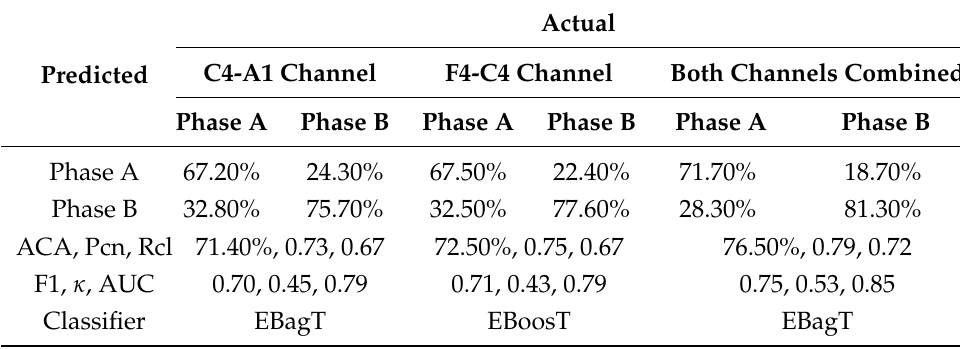
Table 5. Classification performance for insomnia subjects.